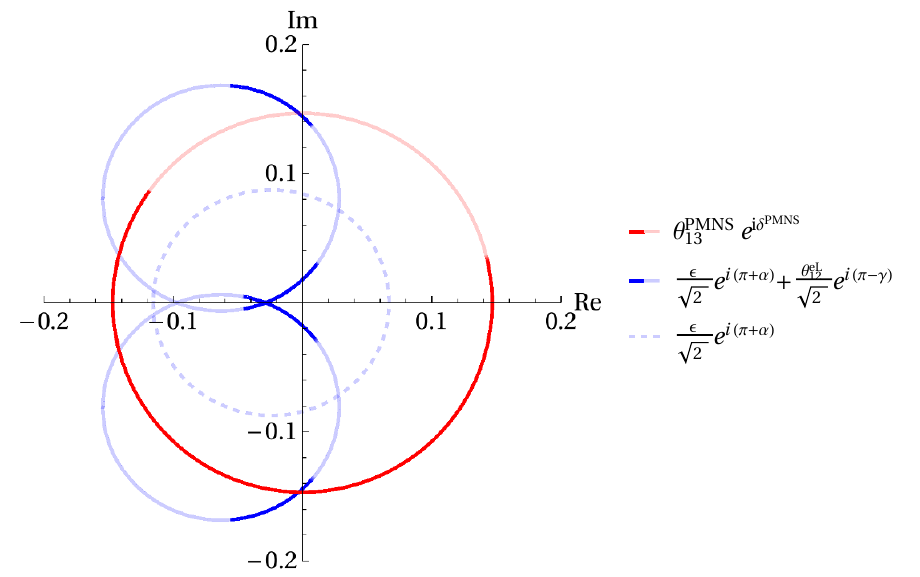
Figure 2 . The di(cid:11)erent terms in eq. (3.9) are illustrated for ( c x ; c y ; c z ) = (3 ; 3 scenario Y (102) (cid:23) , where (cid:15) is taken as a function of (cid:11) induced by neutrino mass (cid:12)tting. There are two solid blue curves according to the two solutions for (cid:13) when (cid:12)tting (cid:18) PMNS represent the experimental 1 (cid:27) range of (cid:18) PMNS the red circle is given by the experimental value of (cid:18) PMNS experimental 3 (cid:27) range of (cid:14) PMNS [13]. The angles (cid:14) PMNS and (cid:11) run from 0 to 2 (cid:25) , and (cid:18) eL is (cid:12)xed by the (cid:12)tting of the Yukawa